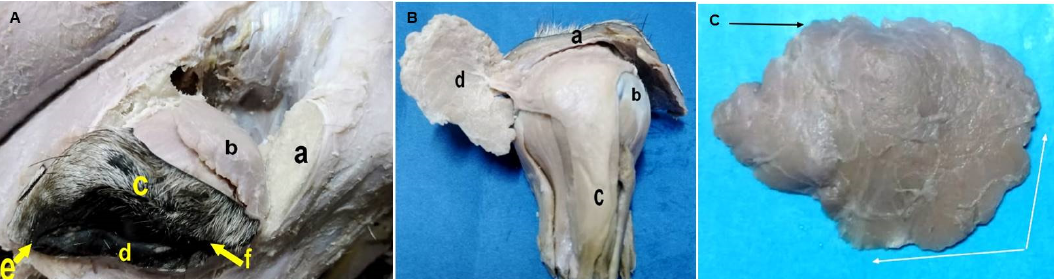
Figure 3. ( A ) A photomacrograph of a dissected formalin-fixed donkey head (after breaking the supraorbital process of the frontal bone), showing the broken supraorbital process of the frontal bone (a), lacrimal gland (b), upper eyelid (c), lower eyelid (d), medial canthus (e), and lateral canthus (f). ( B ) A photomacrograph of a dissected formalin-fixed donkey eye after removal from the orbit showing the upper eyelid (a), eyeball (b), extraocular muscles (c), and lacrimal gland (reflected, d). ( C ) A photomacrograph of an isolated formalin-fixed lacrimal gland of the donkey showing cranial regular border (white arrows) and caudal serrated border (black